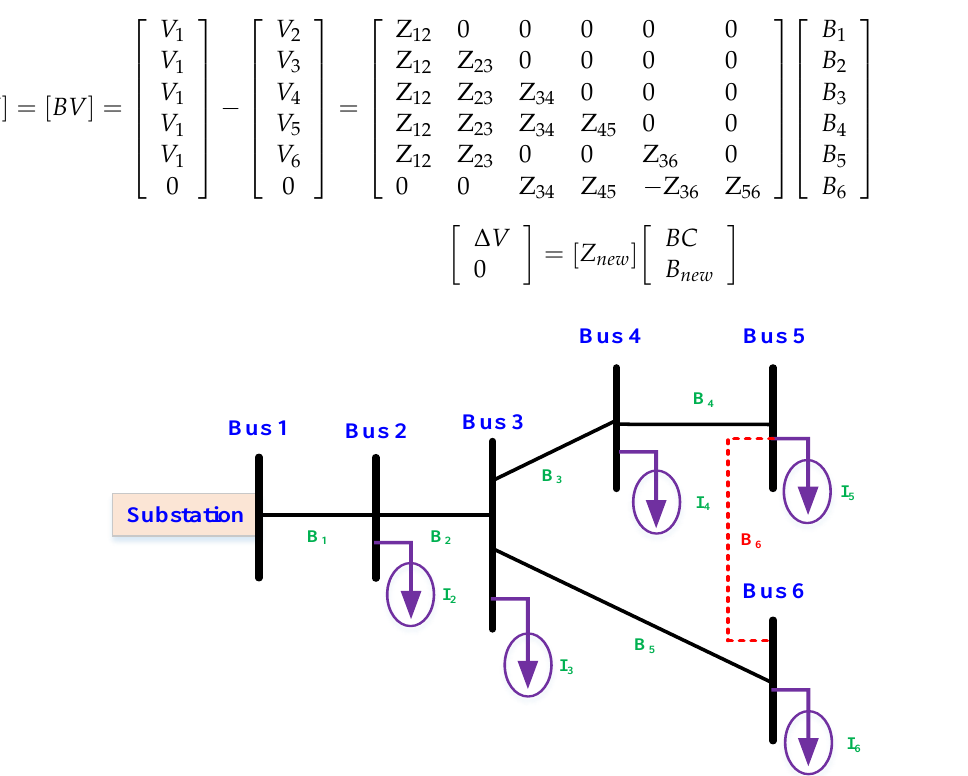
Figure 4. A typical single-line diagram of meshed distribution network.